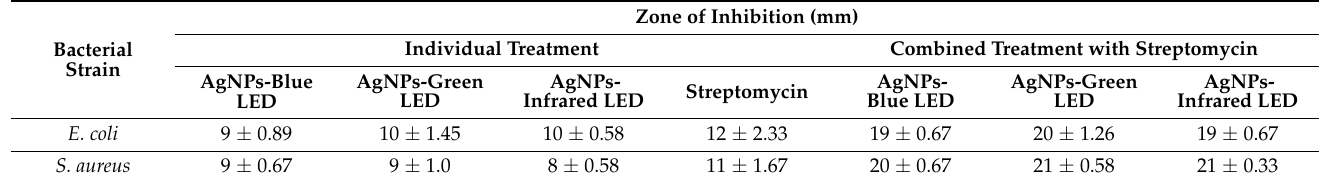
Table 5. Zone of inhibition obtained from the combination of LED-biosynthesized AgNPs and streptomycin against S. aureus and E. coli K 12 was evaluated by the disk diffusion method. Zone of Inhibition (mm) Bacterial Strain